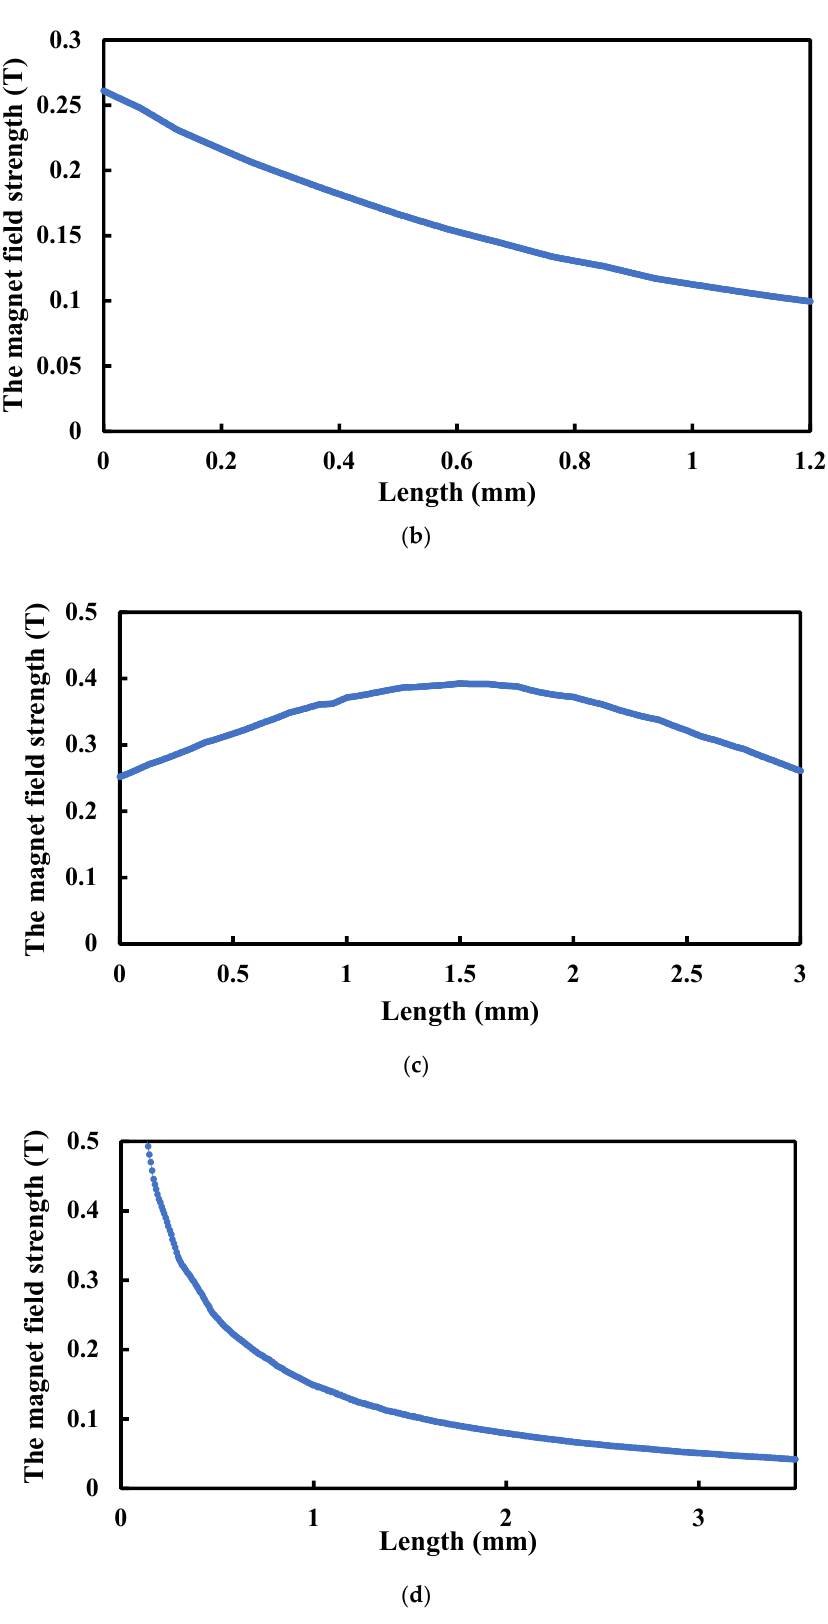
Figure 3. ( a ) The distribution of the magnetic field; ( b ) The strength of the magnetic field in the separation chamber at the vertical direction; ( c ) The strength of the magnetic field in the separation chamber at the horizontal direction; ( d ) The strength of the magnetic field from the separation chamber to the incubation